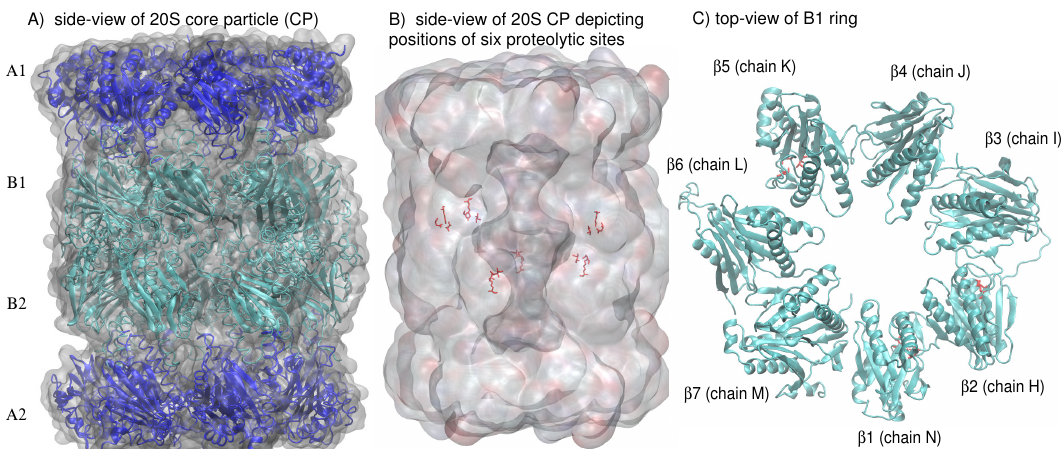
Figure 1. ( A ) A schematic side-view of the 20S proteasome core particle (CP) depicts the four heptameric rings, each consisting of seven subunits, that are stacked on top of each other to form a hollow cylinder. ( B ) A side-view of the 20S CP shows the position of the six proteolytic sites located in the two inner B rings. ( C ) A schematic top-view of the B 1 ring highlights the ordered arrangement of α -helices and β -sheets in each of the seven subunits; the amino acids (Thr1, Asp17, Lys33) composing the proteolytic sites in β 1 (chain N), β 2 (chain H), and β 5 (chain K) are colored in red (stick